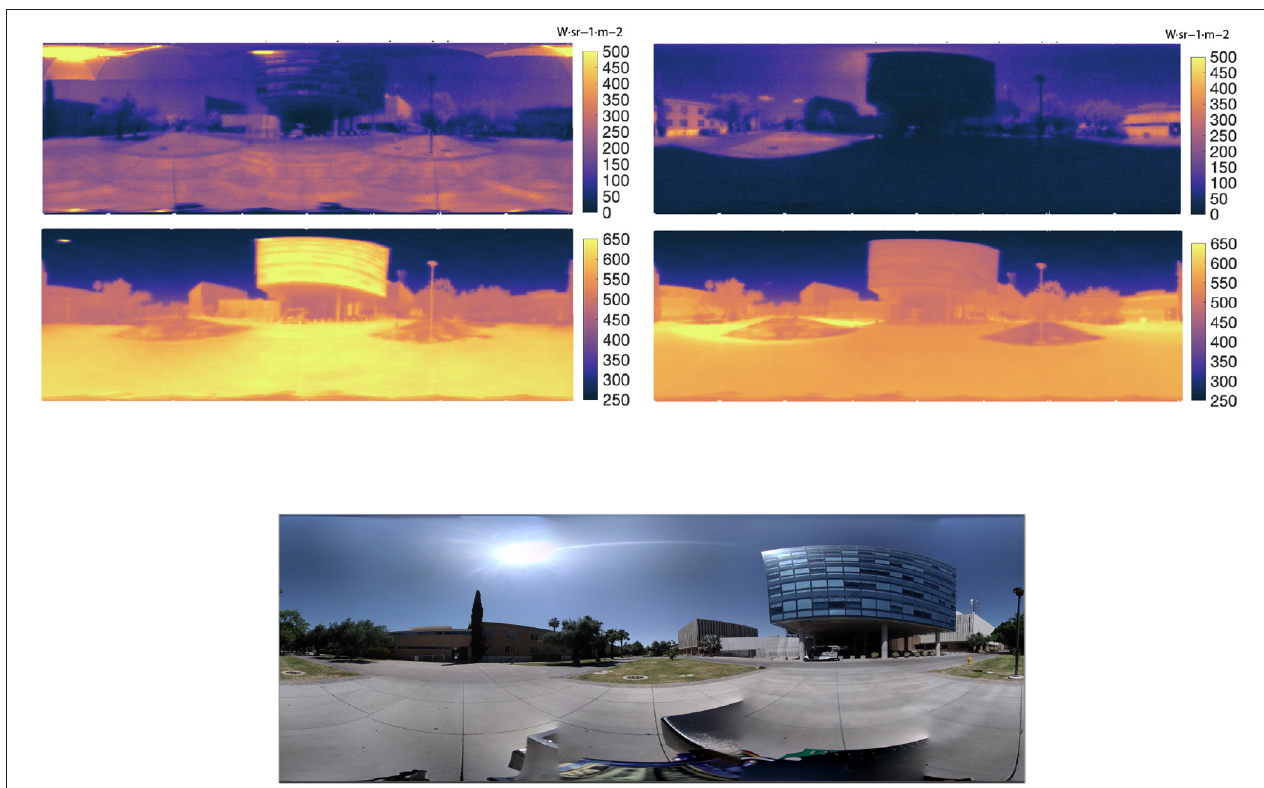
FIGURE 6 | Forest Ave Shortwave 0.3–3 µ m (top) and Longwave 7.7–20 µ m (middle) panorama at 11 am from the SMaRT-SL sensor scan, (right) 11 am scan and (left) 3 pm scan (bottom). Visual panorama at 11 am showing the COOR building and mixture of concrete and grass surfaces. Lambert cylindrical equal area projection used.